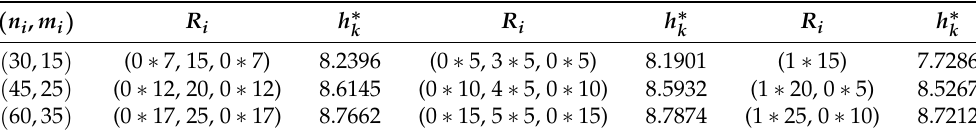
Table 7. The average optimal transformed stress level h ∗ sizes ( n i , m i ) and different censoring schemes R i .